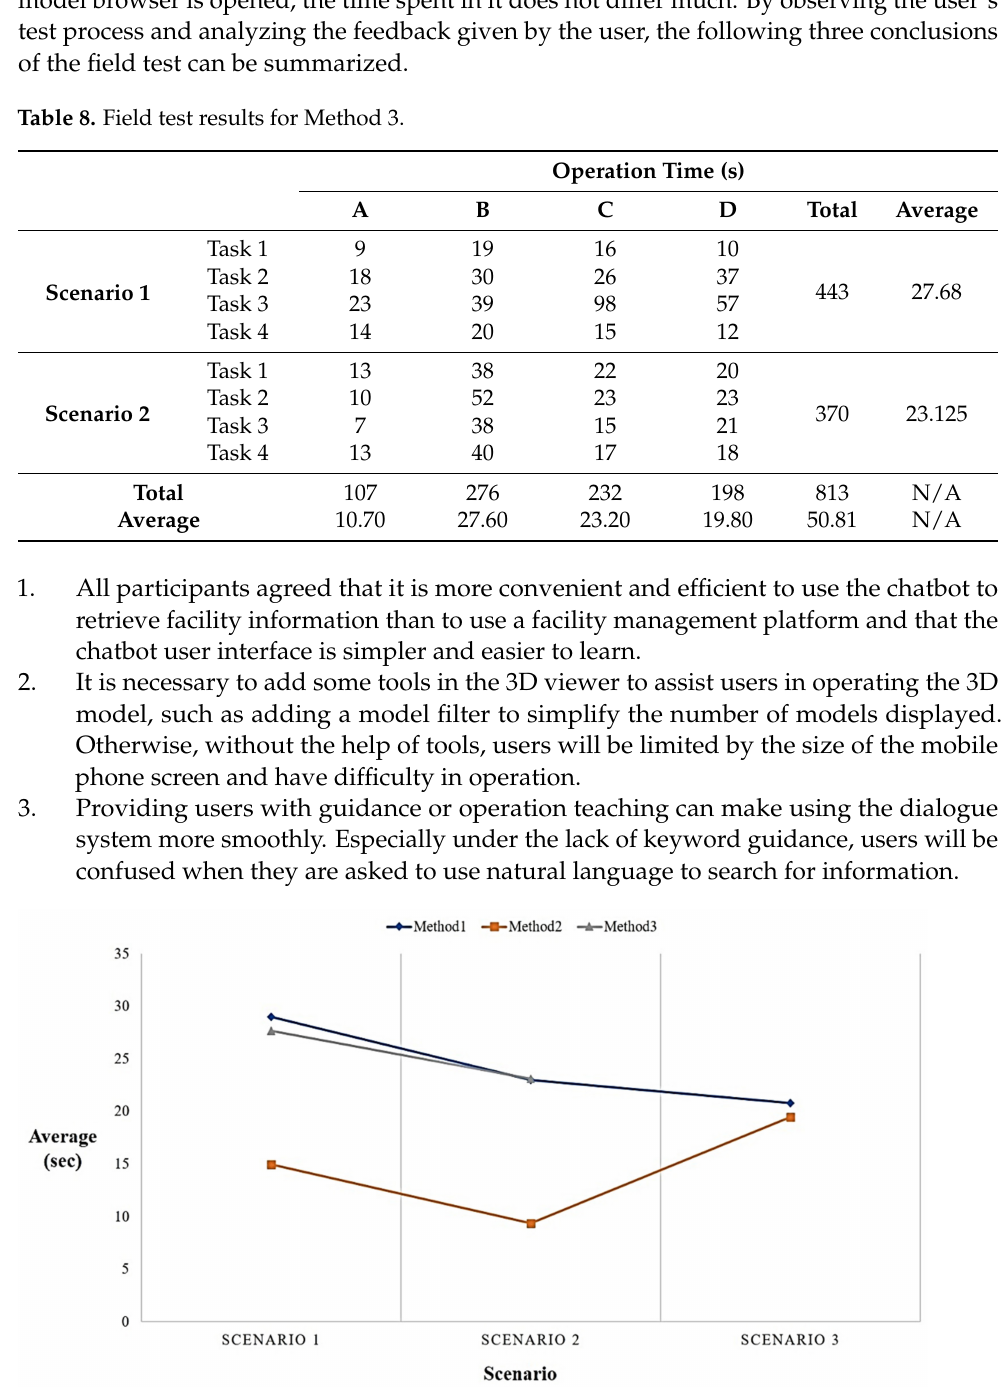
Figure 14. Statistical results of the three